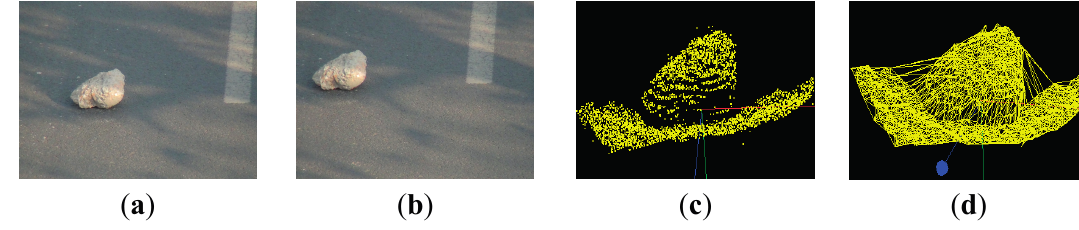
Figure 12. 3D object reconstruction result of boxes. ( a ) left scene; ( b ) right scene; ( c ) point cloud; and ( d ) reconstruction result of boxes.